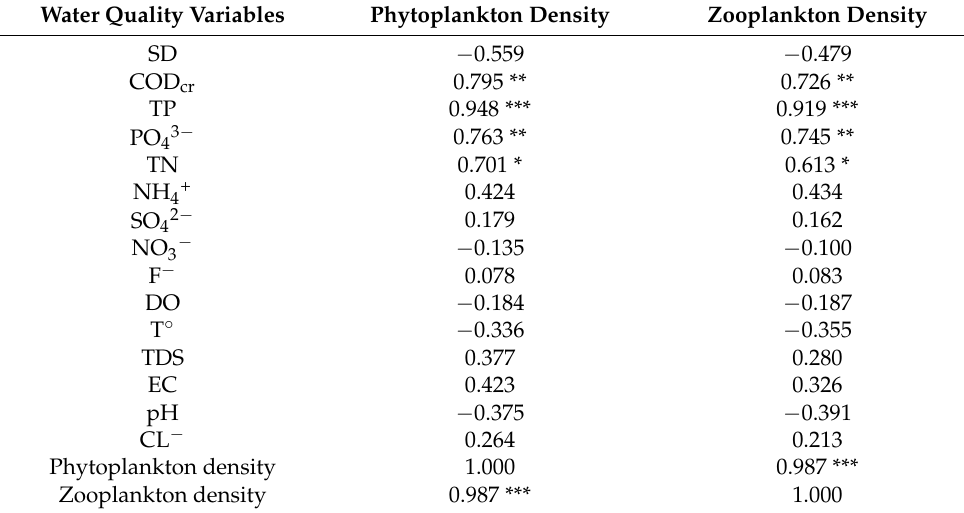
Table 1. Correlation coefficient of Pearson correlation of water quality variables, phytoplankton and zooplankton